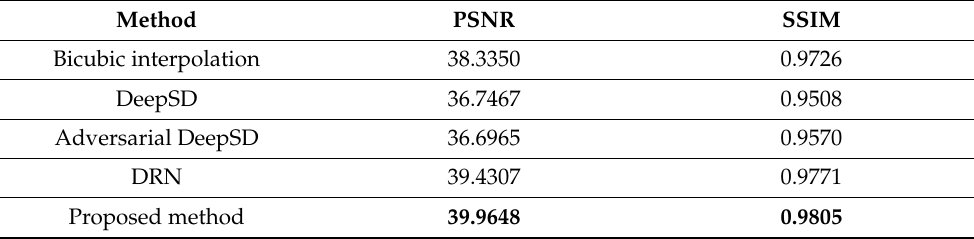
Table 4. Downscaling reconstruction quality of sea surface wind in terms of PSNR and SSIM for the study areas in Figure